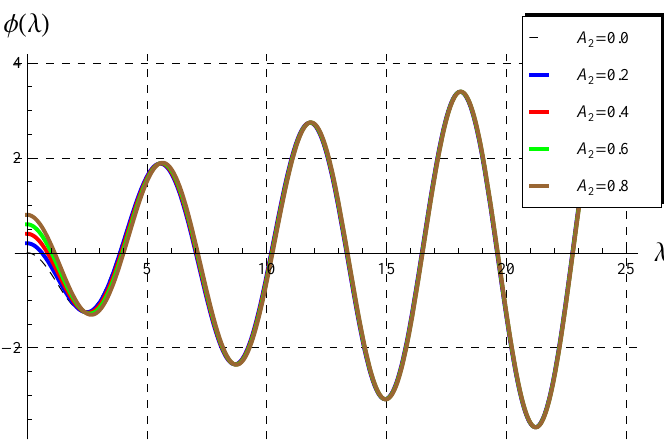
Figure 1. Behavior of φ ( λ ) vs. λ in the range 0 ≤ A 2 < 1. The thin curve (black, dashed) represents the function φ ( λ ) = − λ J 1 ( λ ) ( A 2 = 0).